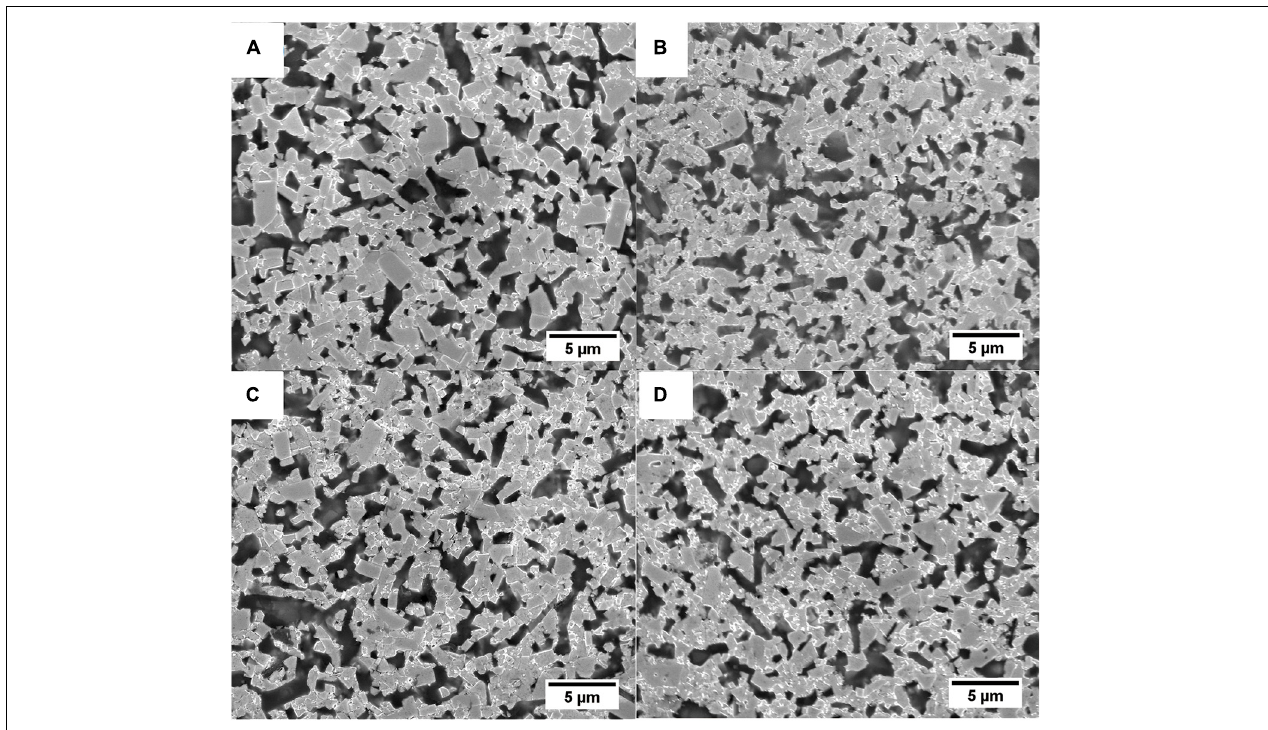
FIGURE 4 | SEM micrographs of the indentation crack paths in (A) 10S0.01B, (B) 10S0.05B, (C) 10S0.1B, and (D)